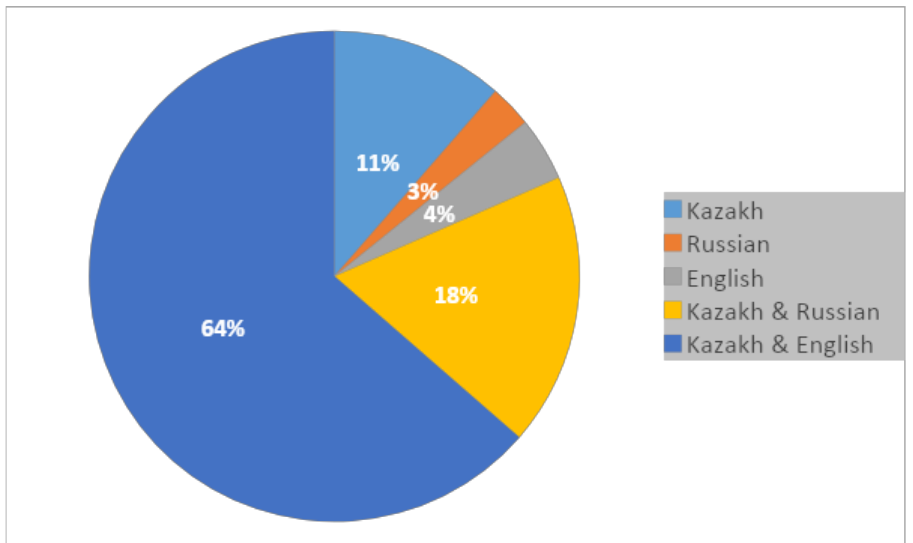
Figure 2. The most prestigious language in Kazakhstan.